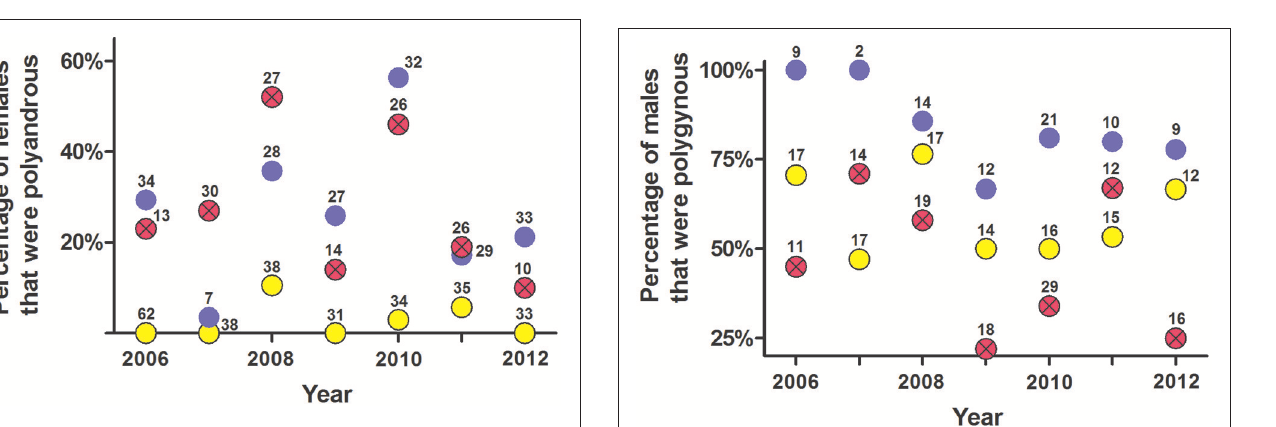
FIGURE 9 | Estimate of the percentage of females per year that were polyandrous from (a) social organization, (b) observations of copulations, and (c) probability of genetic non-exclusion analyses from seven polymorphic microsatellites. These data are from female white-tailed prairie dogs at the Arapaho National Wildlife Refuge, Colorado USA, from 2006 through 2012. Yellow circles are from composition of clans (mean ± SE estimate of females that were polyandrous = 2.7% ± 1.5%); blue circles are from observations of copulations (mean ± SE = 27% ± 6.5%); red circles with Xs are from probability of genetic non-exclusion (mean ± SE = 27% ± 6.0%). The number above each dot indicates the number of females for which we had information for each method.